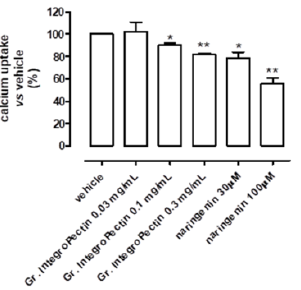
Figure 4. Changes in calcium uptake following the addition of increasing concentrations of grapefruit IntegroPectin or naringenin in the suspension mitochondrial buffer. The vertical bars symbolize the standard errors ( n = 6). Asterisks show a statistically significant difference from the value observed in the hearts of vehicle-treated animals (* p < 0.05; ** p < 0.01).